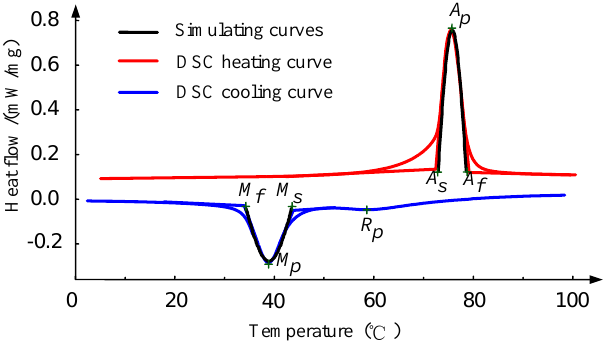
Figure 3. Measured and simulated DSC curves of SMA